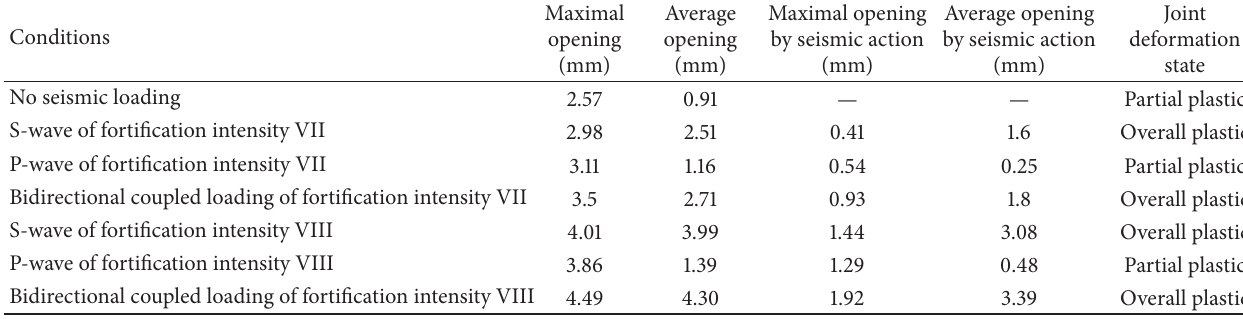
Table 4: Segment opening and joint deformation under different seismic loading conditions.